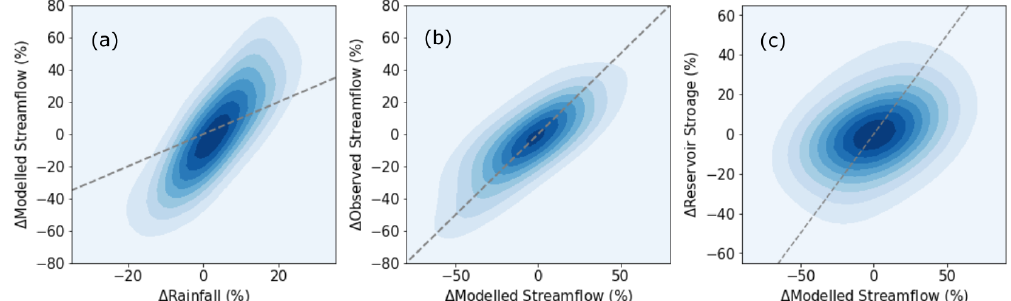
Figure 8. The relationship (dashed gray line: 1 : 1 line) between linear changes from 1984–2015 in (a) annual precipitation ( (cid:49) Rainfall) and modeled streamflow ( (cid:49) Modelled Streamflow), (b) observed streamflow ( (cid:49) Observed Streamflow) and modeled streamflow ( (cid:49) Modelled Streamflow), and (c) reservoir storage ( (cid:49) Reservoir Storage) and modeled streamflow ( (cid:49) Modelled Streamflow).